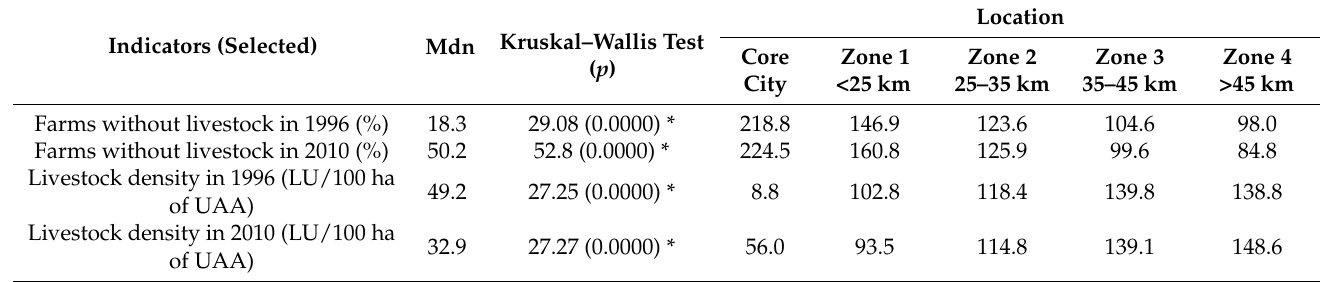
Table 6. Median and medium rank size of selected variables building factor F2, depending on the location.